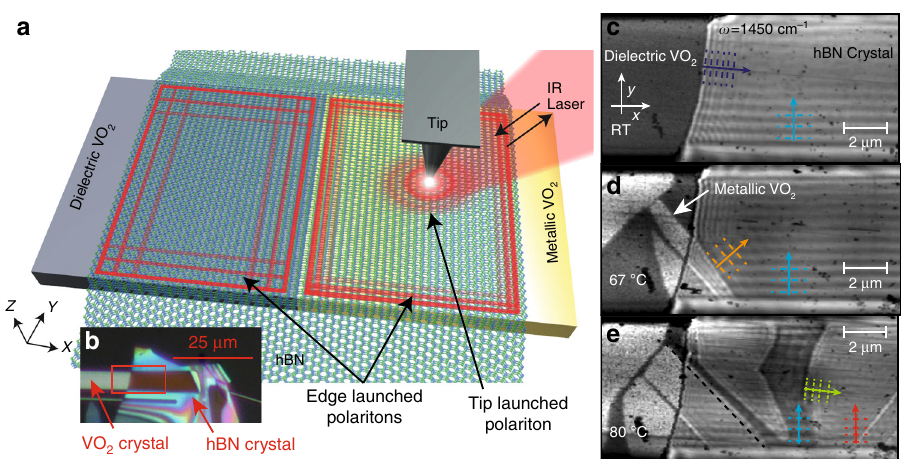
Fig. 1 Actively recon fi gurable hyperbolic metasurface device. a A device and experimental schematic, in which hBN has been transferred on top of a VO 2 single crystal and polaritons are imaged by the s-SNOM tip. b An optical microscope image of the heterostructure. c – e s-SNOM images of the optical near- fi eld at 1450 cm − 1 (6.9 µ m) at various temperatures, showing HPhPs propagating over both metallic and dielectric VO 2 domains. The complex patterns that form are the consequence of multiple interfering waves over the different domains. The arrows show the following: purple highlights tip-launched modes re fl ected from the hBN edge, whereas blue designates the HPhP propagating within the interior of the hBN from the edge of the dielectric VO 2 crystal (boundary with air, suspended hBN). The red arrow highlights the same propagation characteristics as the blue arrow, except for HPhPs propagating over the metallic VO 2 domains. Finally, the orange and green arrows designate HPhPs propagating within the hBN from the domain boundaries between the dielectric and metallic domains of the VO 2 , with the orange (green) propagating over the dielectric (metallic) domains. In e , the black dashed line indicates the edge of the VO 2 metallic domain, extrapolated from the domain outside the hBN